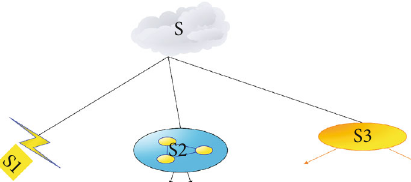
Figure 5: The root node of the decision tree generated by the C4.5